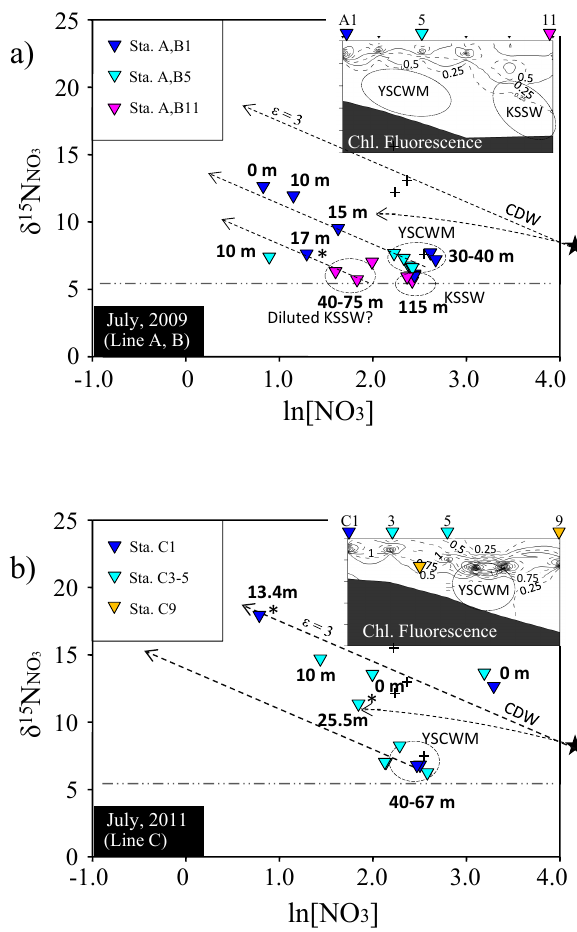
Fig. 9. Nitrate δ 15 N versus [NO 3 ] plotted as its natural logarithm for the samples collected at each location along (a) transects A and B in July 2009 and (b) transect C in July 2011. The star symbol and the lines in the figure are the same as those in Fig. 8. The cross section of transect B is